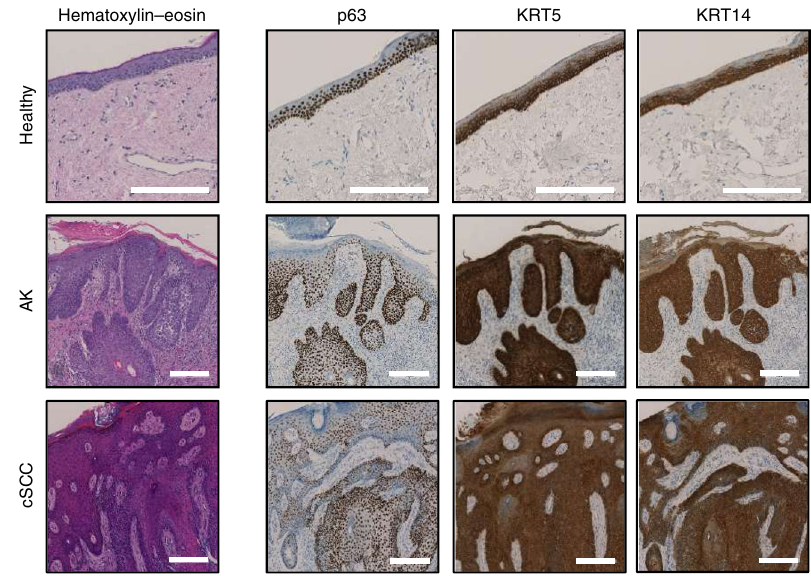
Fig. 4 AK and cSCC express epidermal stem cell markers. The fi gure shows representative hematoxylin and eosin stainings, as well as p63, keratin K5, and keratin K14 immunostainings in epidermis from healthy donors, AK and cSCC patients, respectively. Ectopic expression of the three epidermal stem cell markers was observed in AK and cSCC samples. Scale bars, 200 µ